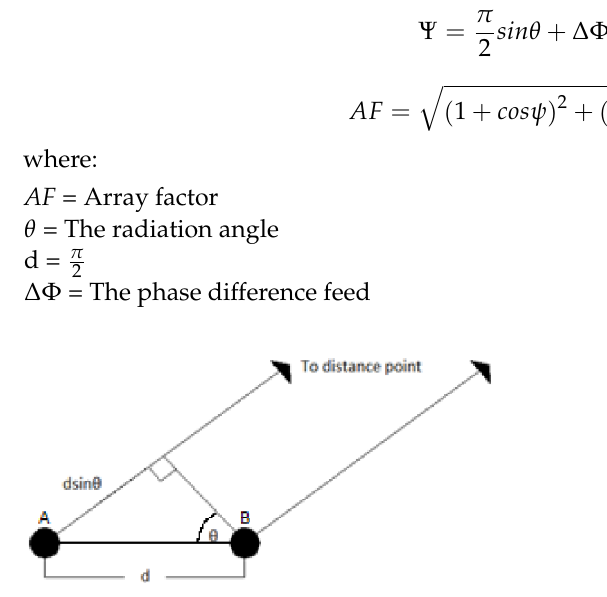
Figure 2. The geometry of A and B phased-array isotropic radiators.